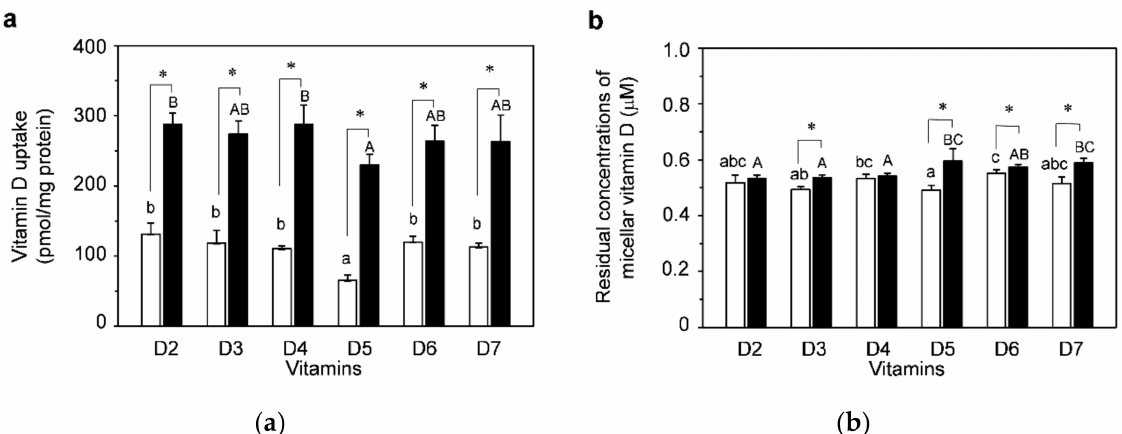
Figure 2. Uptake of vitamin D solubilized in mixed micelles by differentiated Caco-2 cells and the effects of lysophosphatidyl- choline. Differentiated Caco-2 cells were incubated for 2 h with vitamin D in mixed micelles without lysophosphatidylcholine and mixed micelles with lysophosphatidylcholine, called NoPC mixed micelles (open bars) and lysoPC mixed micelles (filled bars), respectively. ( a ) Vitamin D uptake by differentiated Caco-2 cells. ( b ) Residual concentrations of vitamin D in the mixed micelles (micellar vitamin D) after 2-h incubation with the cells. Data are presented as the means ± standard deviation of four wells in a single experiment. Replicate experiments showed a similar trend. Statistical analyses were performed between NoPC mixed micelle and lysoPC mixed micelle in same vitamin D, among 6 kinds of vitamins D in NoPC mixed micelles, and among 6 kinds of vitamins D in lysoPC mixed micelles in each graph. The asterisk indicates a value with significant difference as determined by unpaired t -test ( p < 0.05). Values not sharing a common letter were significantly different as determined by Tukey–Kramer test ( p <